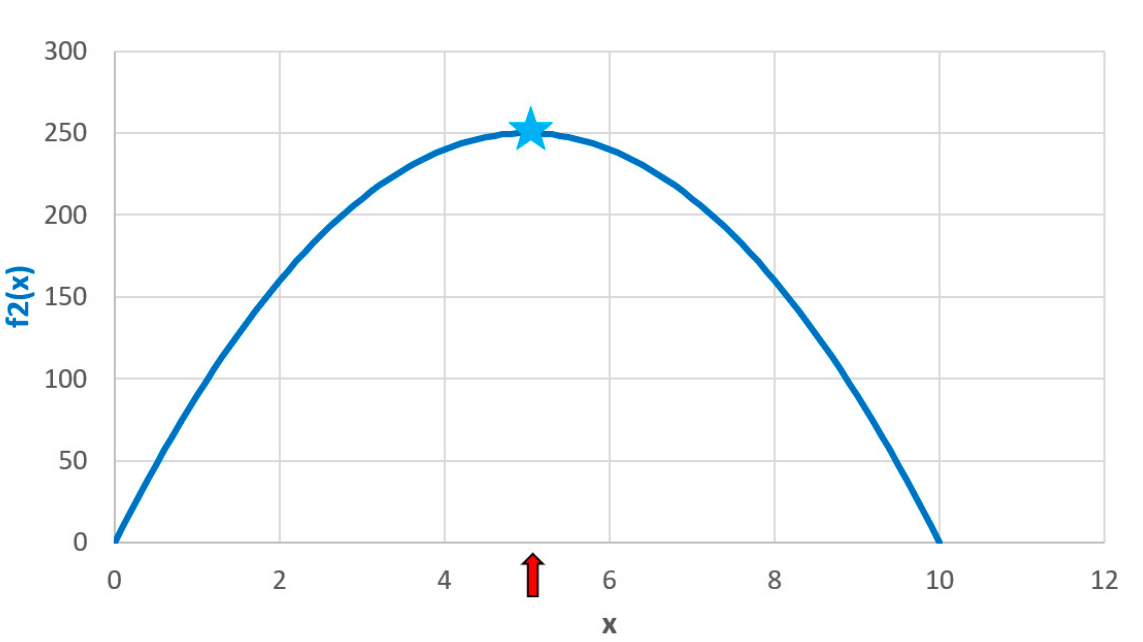
Figure 4. The value of the expected net profit of BLUE, caused by expected RED losses.